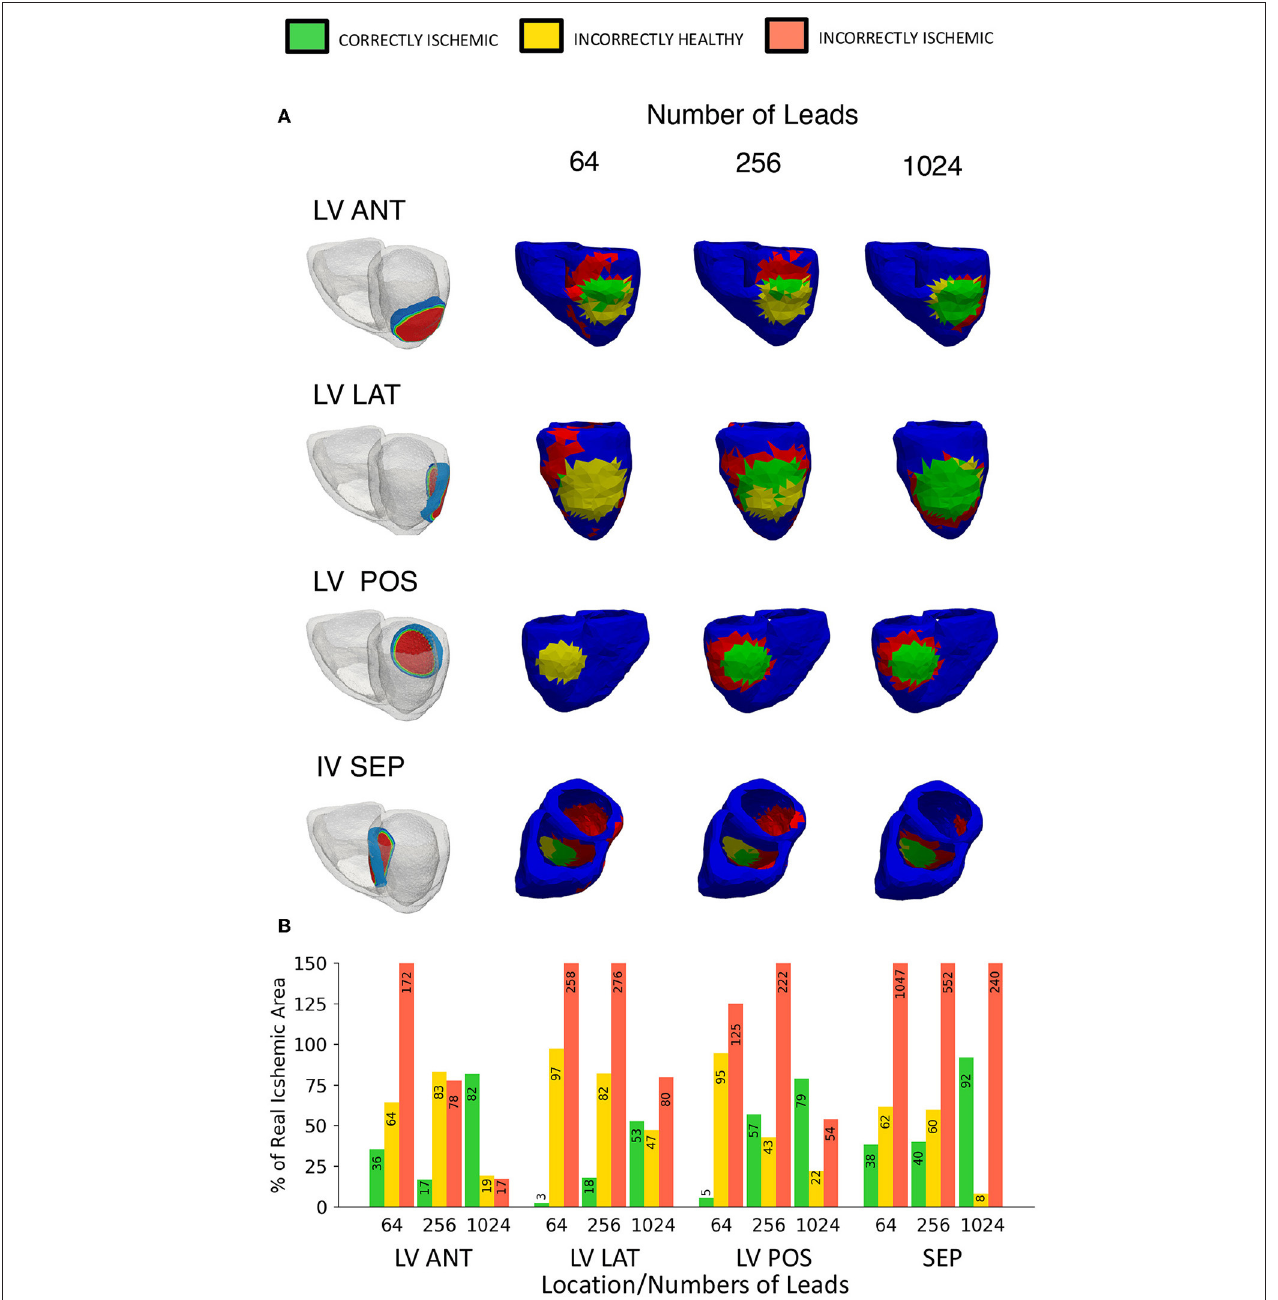
FIGURE 10 | Variable location ischemic lesion detection results using traffic light representation. (A) Location vs. number of leads diagram showing the “traffic light” representation of the ischemic lesion detection results, a head on lesion view is shown for each location. First column shows the location of the ischemic lesion on the ventricle, remaining columns show a head on lesion view of the results (B) A bar chart visualizing the “traffic light” data taken from the whole geometry as views in (A) only show a single view. Please note that some bars go above the height of the y axis, bar numbers are present on each bar to aid with this